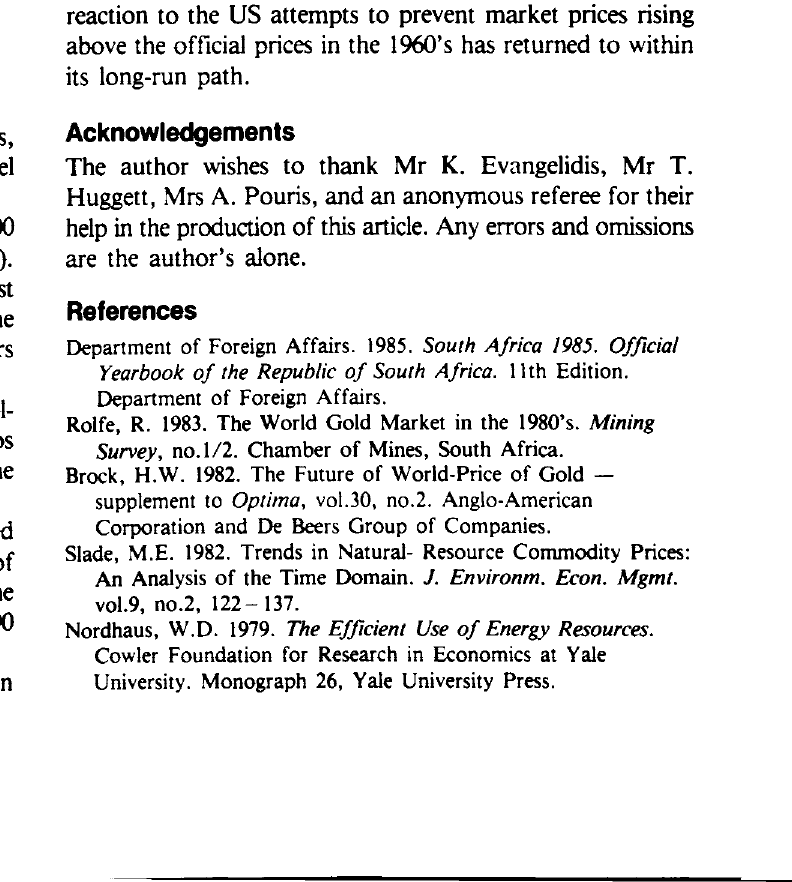
$5,18 per barrel for the year 1984. In 1983 constant dollars, the prices are US $19,07 per barrel and US $15,46 per barrel